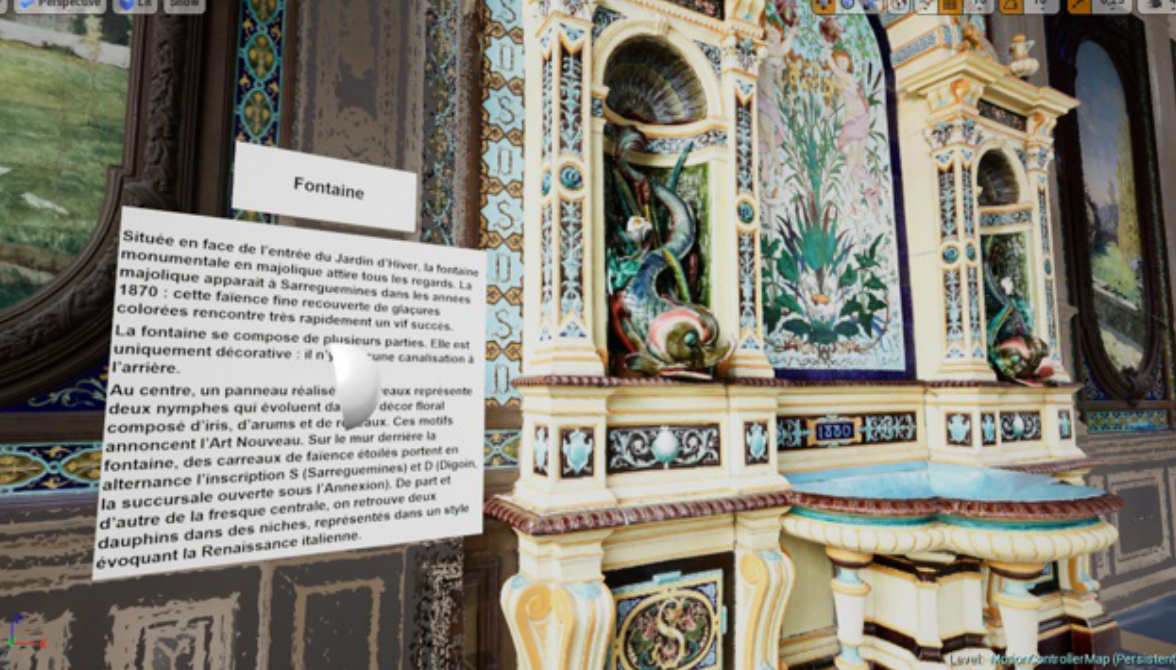
Figure 9. Virtual visit with Unreal Engine